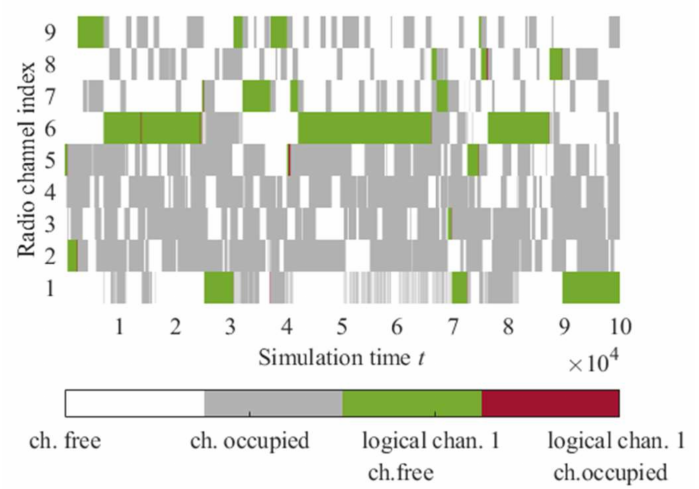
Figure 14. Radio channels activities with logical channel